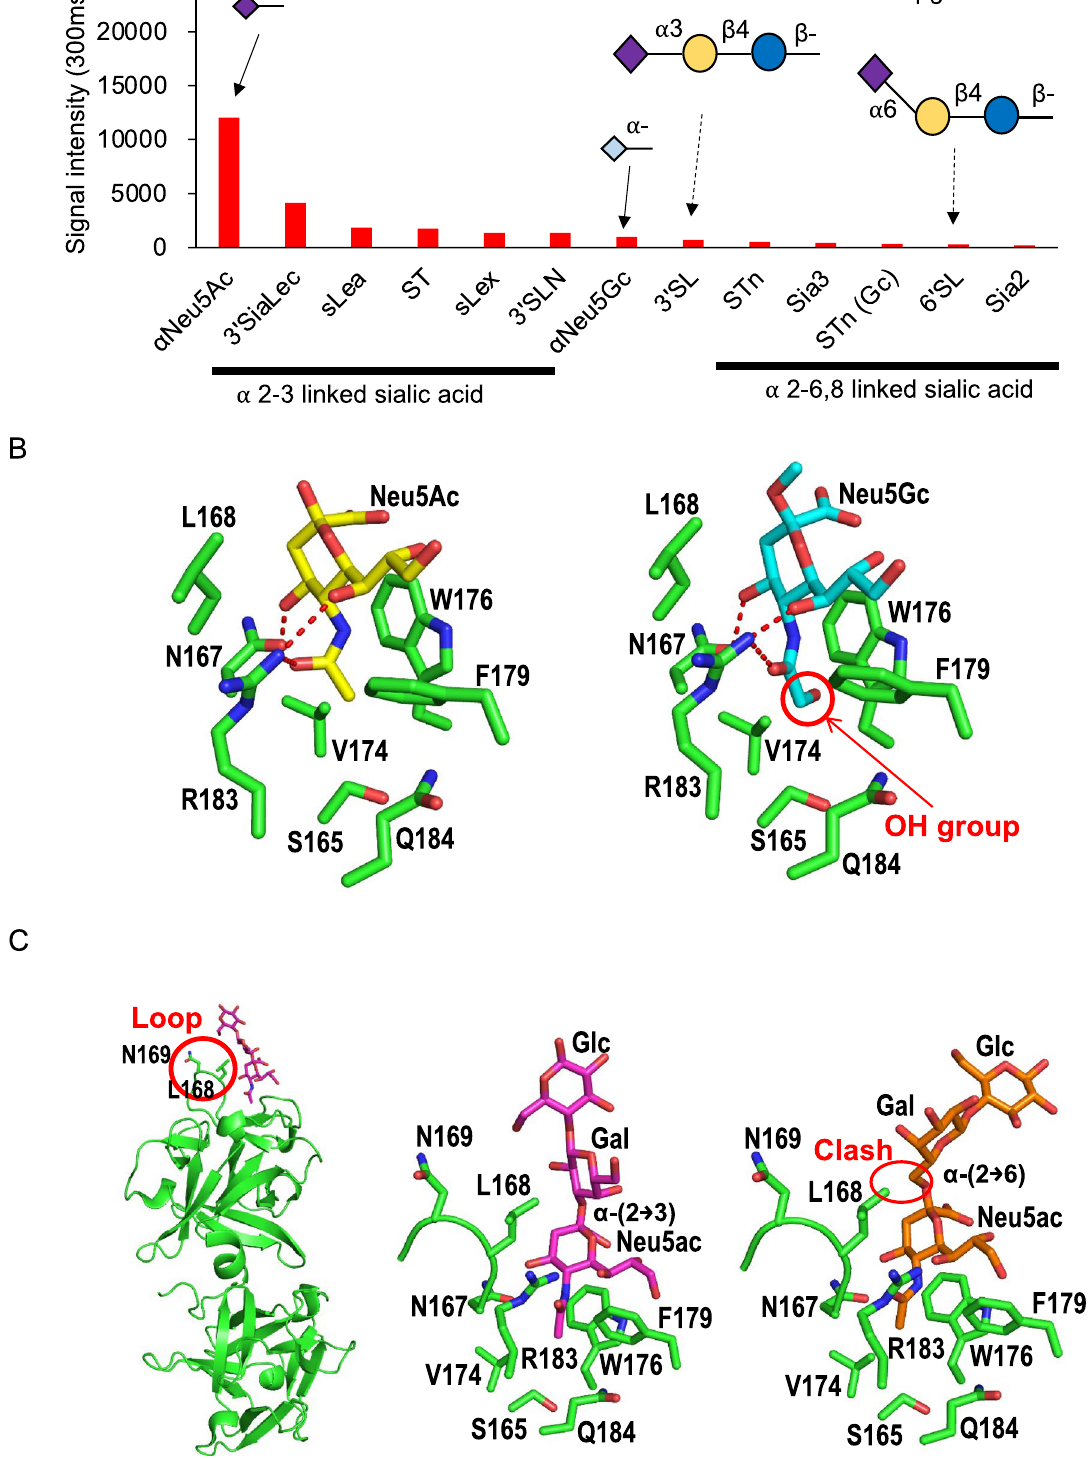
Figure 4. Analysis of Rn specificity. ( A ) Signal intensities of Cy3-labeled Rn to sialic acid terminal glycans. Comparison of binding to Neu5Ac and Neu5Gc are shown in solid arrows while α-(2 → 3) Neu5Ac and α-(2 → 6) Neu5Ac binding intensities are shown in dotted arrows. Cartoon representations of glycan structures are shown on top of each corresponding arrow. ( B ) Model of the area near the binding site of HA1 bound to Neu5Ac (PDB ID, 3AHI). Neu5Ac was modified to Neu5Gc and superimposed to the model. (C) HA1 bound to Neu5Ac model (PDB ID, 3AHI) was used and sugar was substituted with α-(2 → 3) Neu5Ac and α-(2 → 6) Neu5Ac (3SiaLac, PDB ID, 4EN6; 6SiaLac, PDB ID, 4EN8). The models of 3SiaLac and 6SiaLac were then placed in the structure of HA1 based on the position of sialic